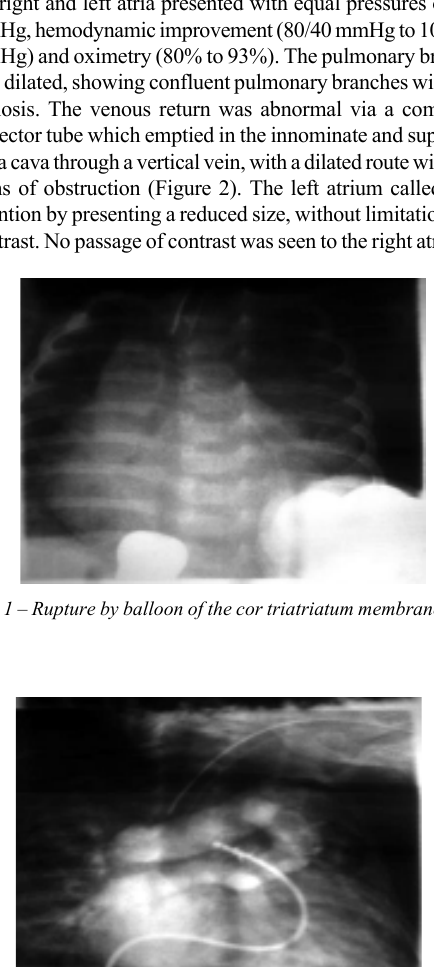
Fig. 2 – Cineangiocardiographic study demonstrating the venous return of the total anomalous pulmonary venous connection of the pulmonary veins in the superior vena cava (supracardiac) The operation was performed two days after the cineangiocardiogram, with deep hypothermia and total cardiac arrest. The time of cardiopulmonary bypass (CPB) was 240 minutes (202 and 38 minutes) and the myocardial ischemia time was 130 minutes, with 9 minutes of total cardiac arrest at 18 ºC. The right atrium was opened and an interatrial shunt of a moderate size and with thick edges was found near to the inferior vena cava. Amplifying the interatrial